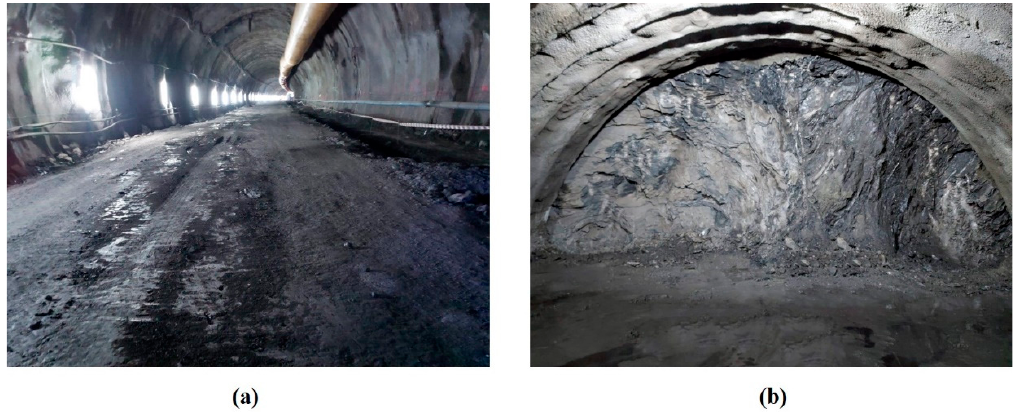
Figure 7. Railway tunnel excavated using the top-heading-and-benching method: ( a ) full face and forced duct, and ( b ) top heading.